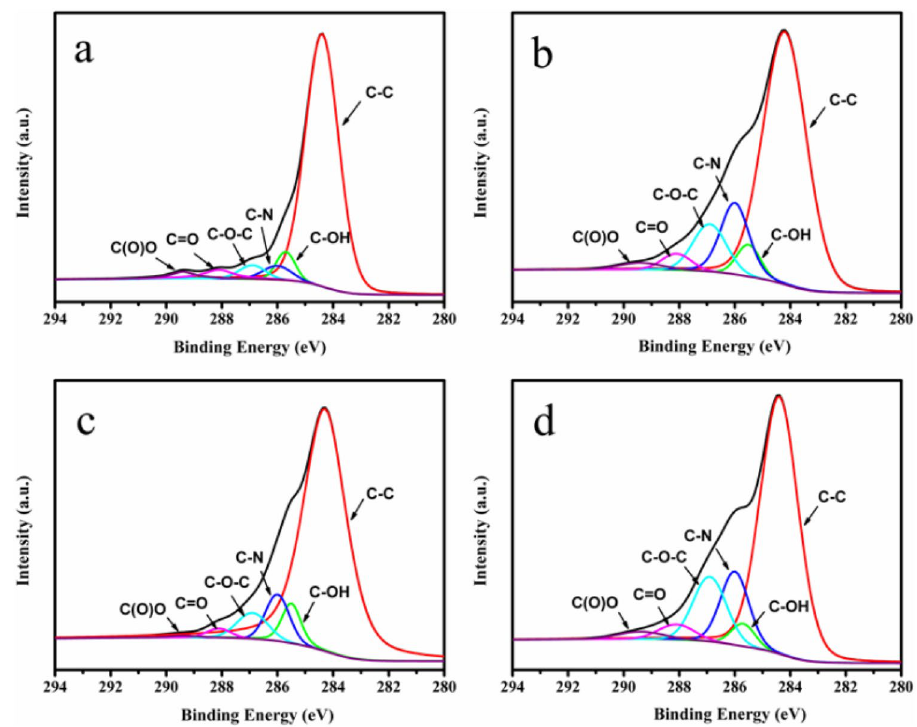
Figure 6. XPS spectra of ( a ) P-GP-1, ( b ) P-GP-2, ( c ) P-GP-3, and ( d ) P-GP-4 binary artificial nacre nanocomposites.